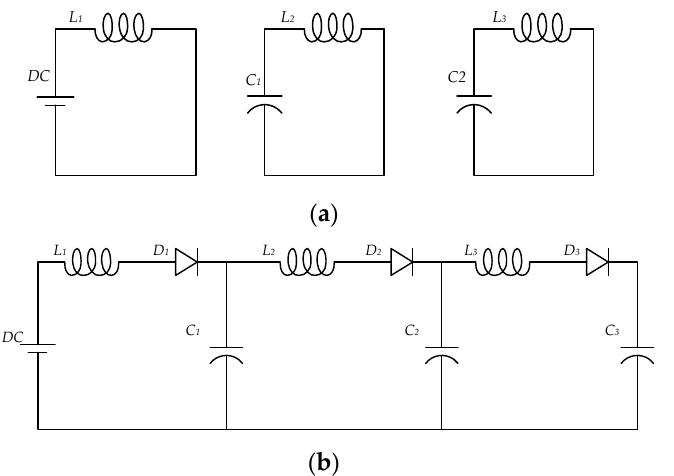
Figure 4. Connection method in D Ts and (1 − D ) Ts of three-order boost converter. ( a ) Mode Ⅰ , ( b ) Mode Ⅱ.